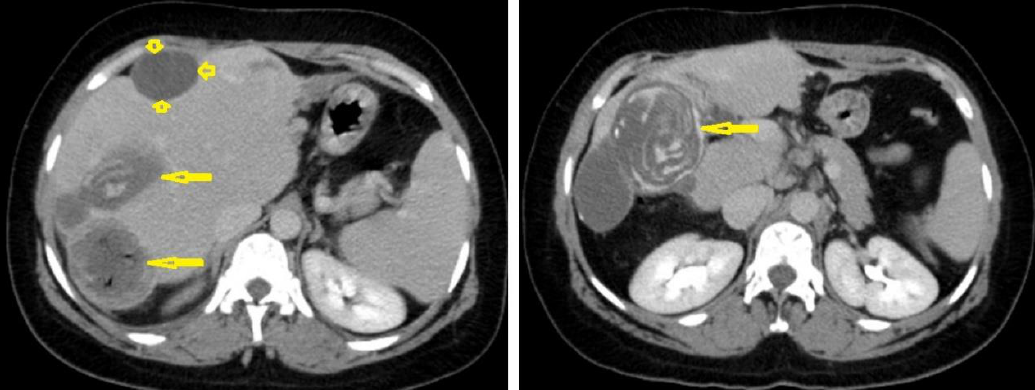
Figure 19. Selected axial sections of CT images of a 30-year-old female with a previous surgery for a liver hydatid cyst presenting with abdominal pain showing remnants of the hydatid cyst (arrows) and another hydatid cyst (arrow heads).